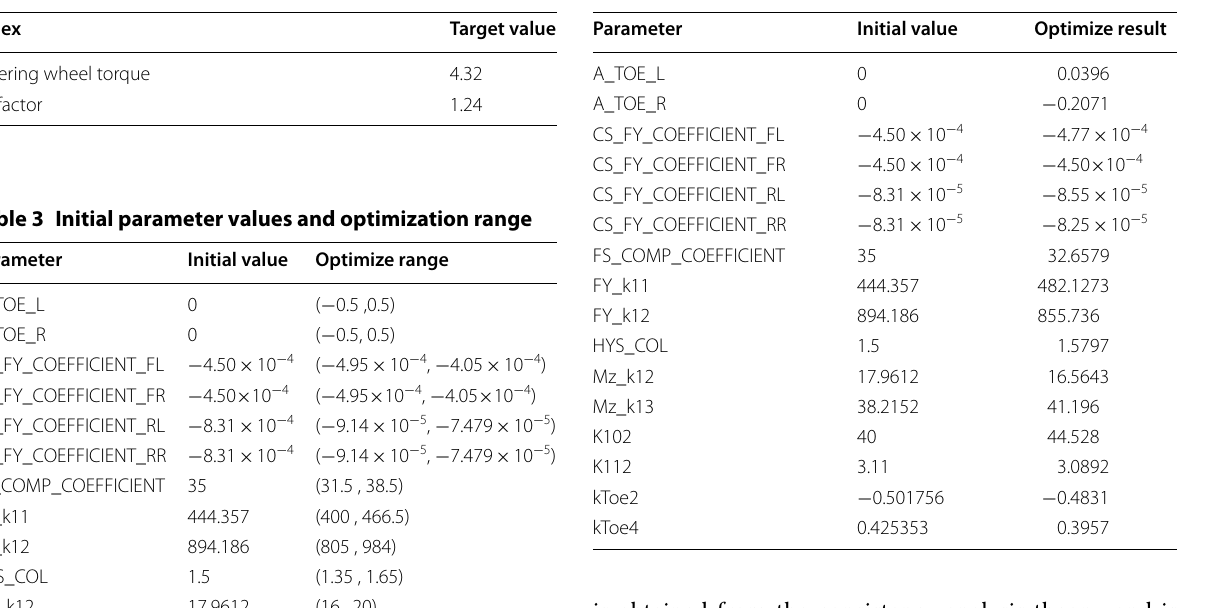
Table 2 Steering performance target value